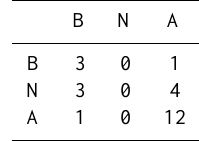
Table 5. Contingency table between the ACM observed and the forecasted categories shown in Table 4, during ASO 2010. Cate- gories are: Below (B), Normal (N) and Above (A). Hit Rate: 62.50, Skill Score: 43.80, LEPS: 45.90, Gerrity Score: 62.50, POD B and A: 42.80 and 70.60 and FAR B and A: 25 and 7.7, respectively. Spearman and Kendall correlation values between observed and forecasted categories are 0.56 and 0.53, respectively, both with p- values <